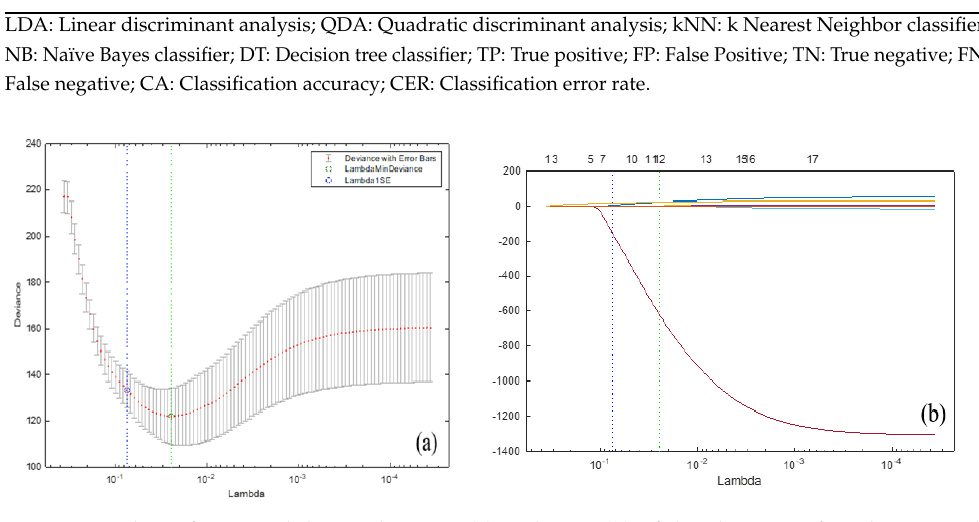
Figure 20. Plots of cross-validation deviance ( a ) and trace ( b ) of the elastic net fit, where λ with minimum error of cross-validation and α = 0.9 is located at the green circle and dotted line; see abbreviations in